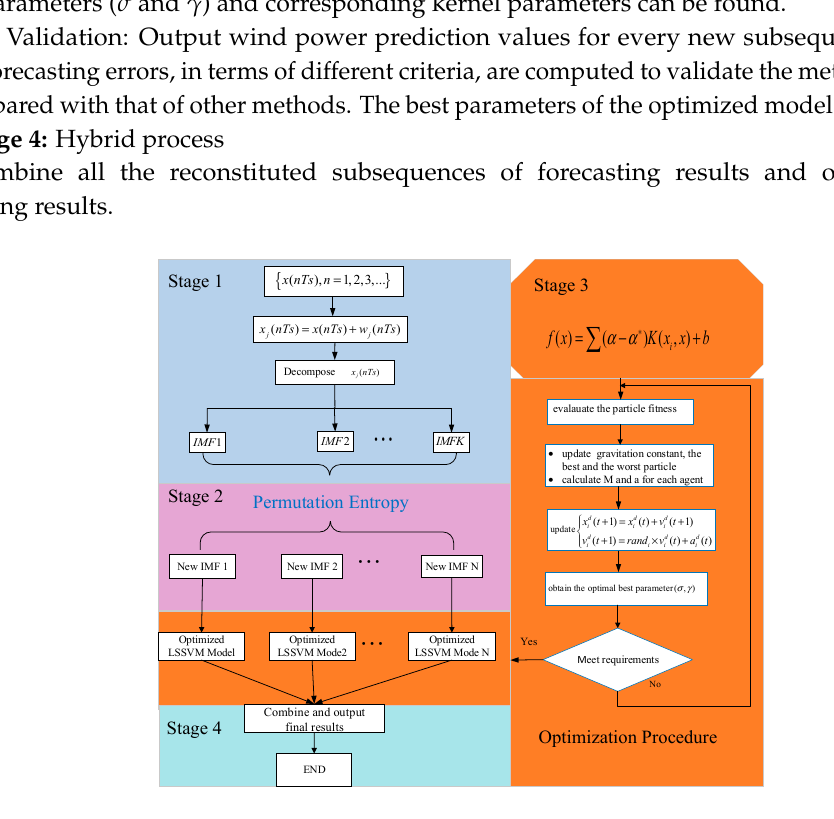
Figure 3. The overall framework of the proposed model.